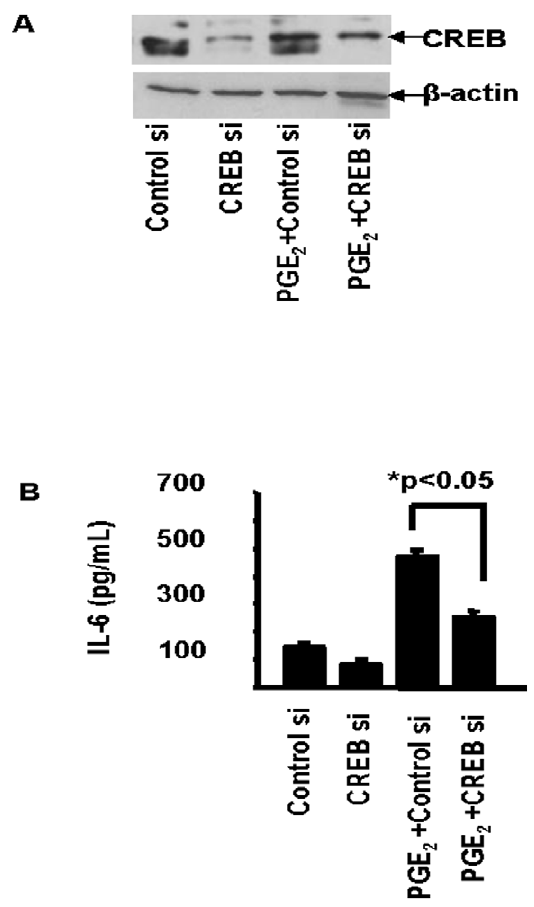
Figure 7. Knockdown of CREB with siRNA attenuates PGE 2 - induced IL-6 protein expression in orbital fibroblasts. A : siRNA specific to CREB (CREB si) or scrambled siRNA (Control si) was transfected into 80% confluent cultures. Representative Western blot analysis demonstrates the impact of the knockdown of CREB protein. B : Media were subjected to IL-6 ELISA. Data are expressed as the mean 6 SD of three independent determinations These results were represen- tative of those in two other orbital fibroblast strains.